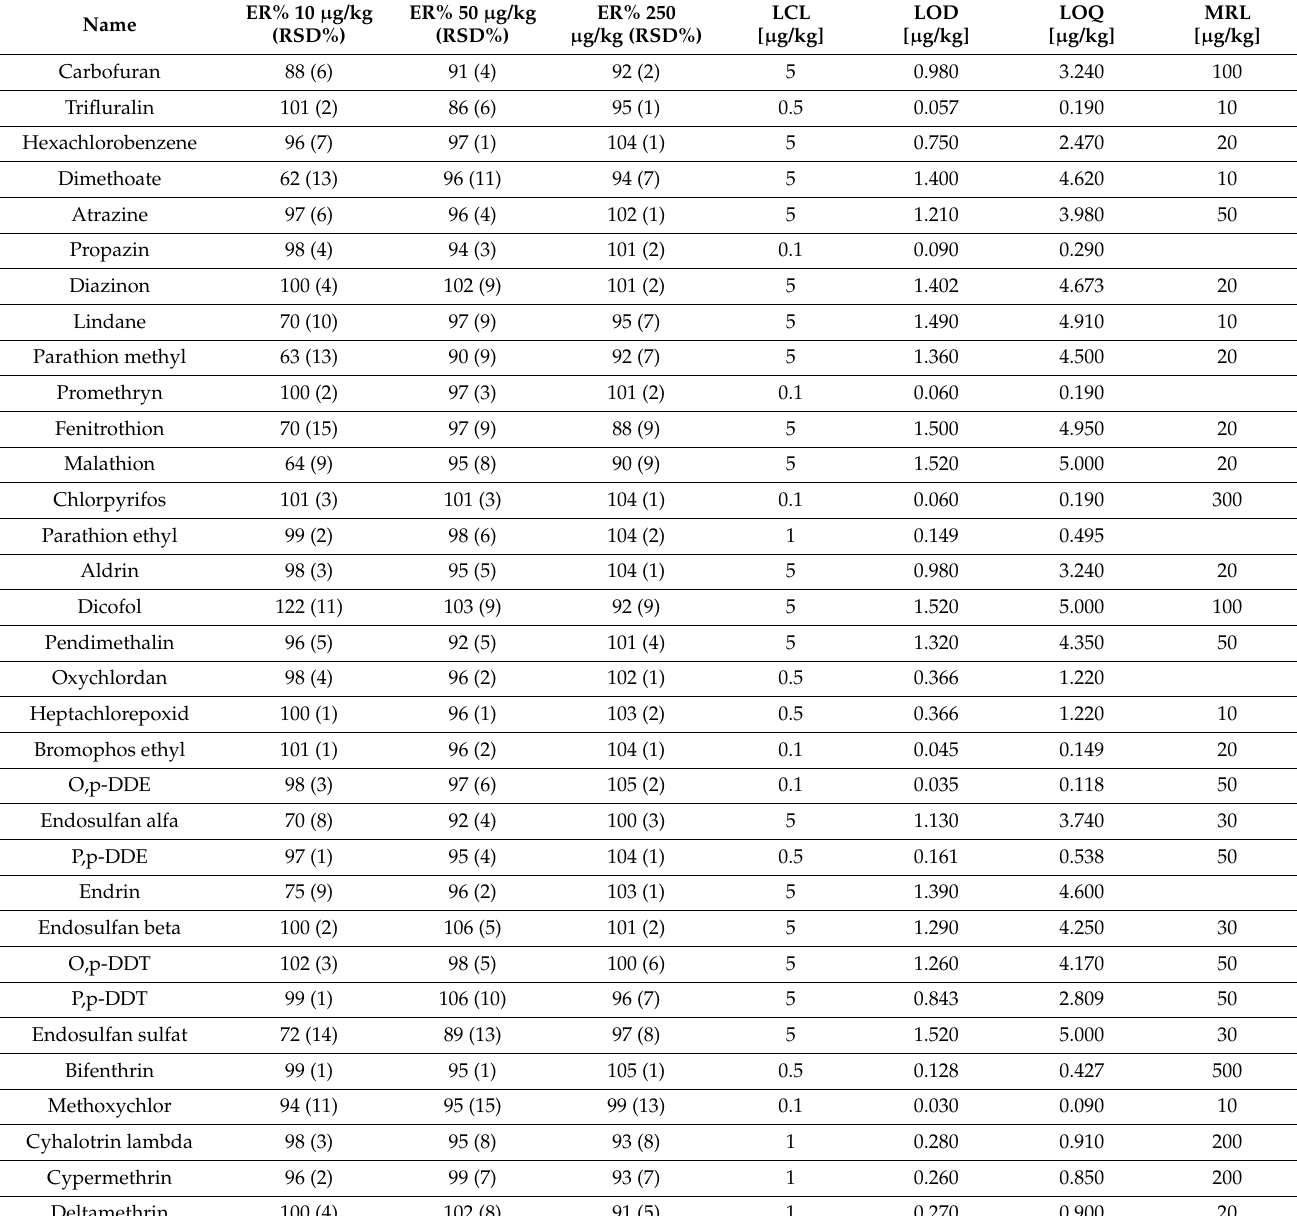
Table 2. Validation results of the developed analytical method and MRLs of pesticides in cotton textile